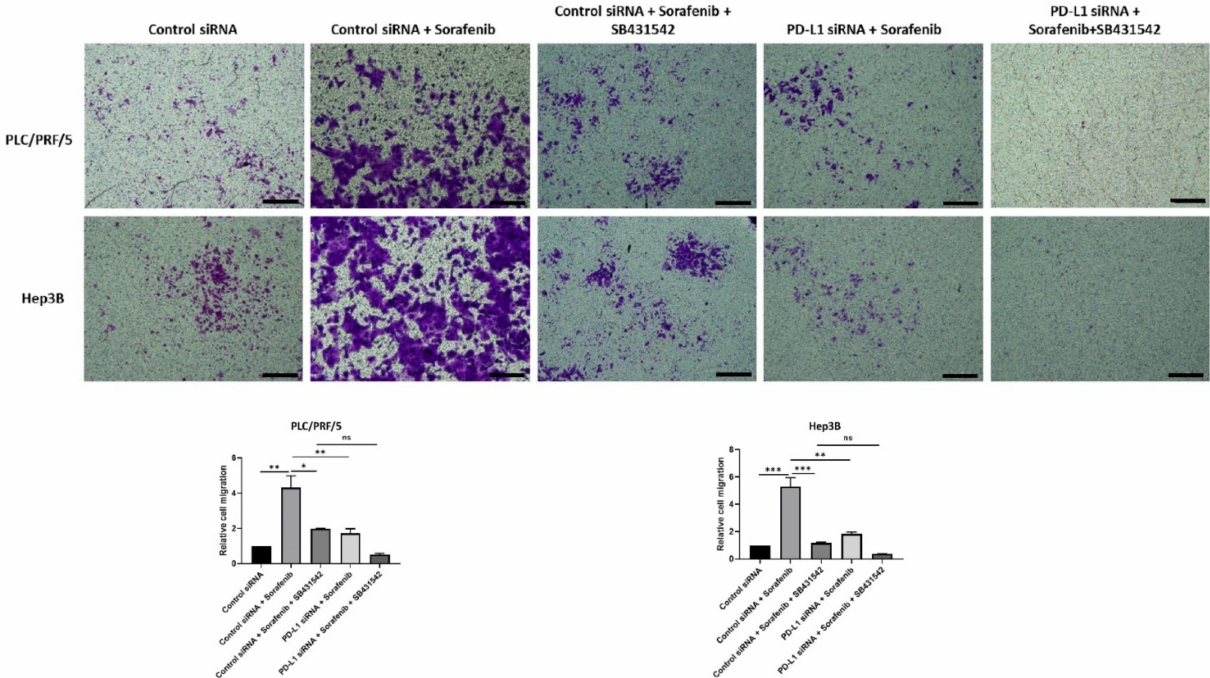
Figure 11. Combination treatment of Sorafenib with PD-L1 knockdown and SB431542 can reverse Sorafenib-induced migration in HCC cells. Migratory ability of PLC/PRF/5 and Hep3B cells was attenuated by combination treatment of Sorafenib with PD-L1 knockdown and SB431542, as revealed by images of the transwell migration assay (scale bar = 500 µ m). The number of motile cells was determined by measuring the absorbance of Crystal Violet staining ( n = 3, * p < 0.05, ** p < 0.01, *** p <